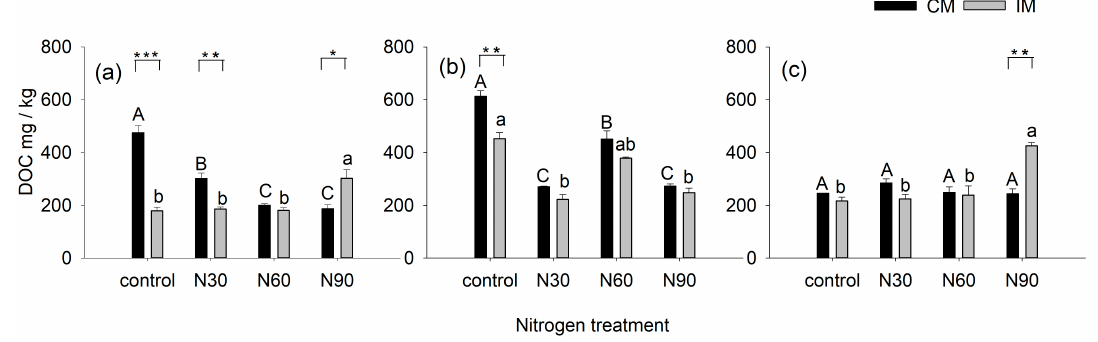
Figure 1. Dissolved organic carbon (DOC) in surface soil (0–20 cm) in different seasons (( a ) April; ( b ) July; ( c ) December) under different management practices (CM: conventional management; IM: intensive management) and four nitrogen addition treatments (N30: 30 kg N ha − 1 year − 1 ; N60: 60 kg N ha − 1 year − 1 ; N90: 90 kg N ha − 1 year − 1 and Control: N-free). Vertical bars indicate the standard error of three replicates. Different uppercase letters indicate significant differences among N addition rates under CM treatments ( p < 0.05). Different lowercase letters indicate significant differences among N addition rates under IM treatments ( p < 0.05). Asterisks indicate significant differences between CM and IM at the same N addition rate (* p < 0.05, ** p < 0.01, *** p < 0.001).